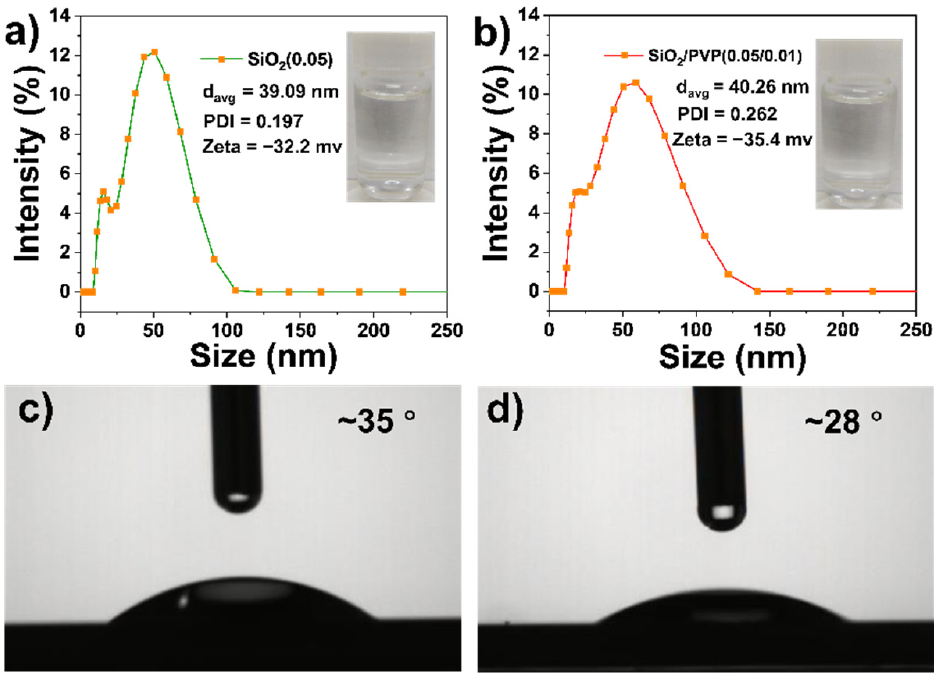
Figure 2. Particle size distribution of ( a ) SiO 2 (0.05) and ( b ) SiO 2 /PVP (0.05/0.01) dispersions in water; contact angles of ( c ) SiO 2 (0.05) and ( d ) SiO 2 /PVP (0.05/0.01) on silicon wafers.